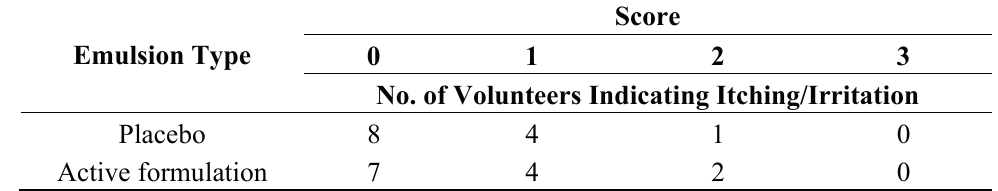
Table 3. Score allocated by volunteers ( n = 13) to placebo and formulation on the basis of itching/irritation. Score 0 is attributed in absence of erythema; Score 1 stands for mild erythema; Score 2 stands for moderate erythema; Score 3 stands for severe